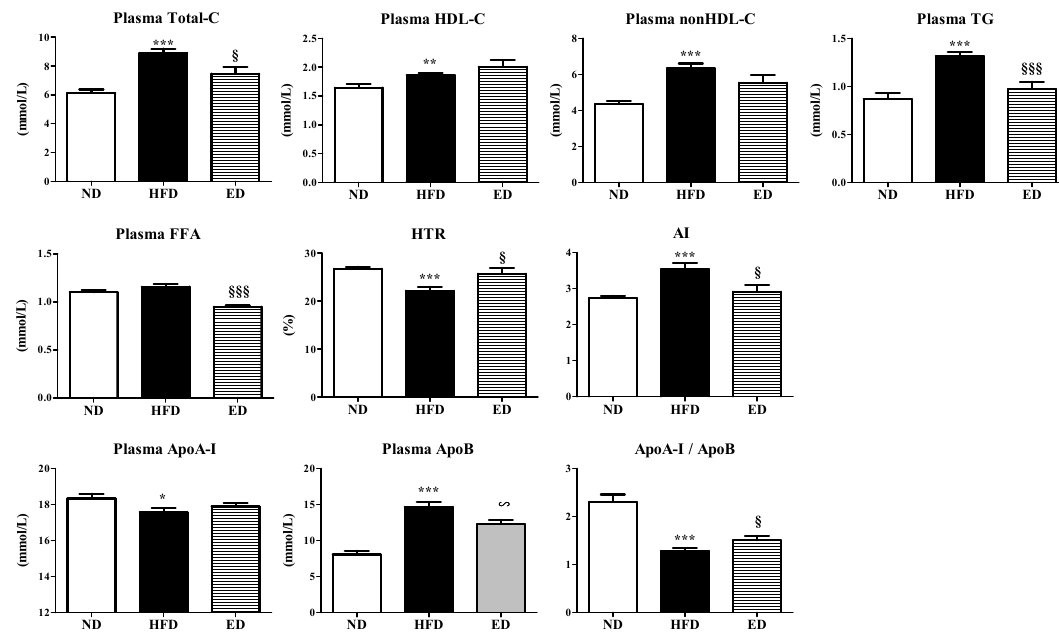
Figure 2. Effect of eriodictyol treatment on the plasma lipid levels in C57BL/6N mice fed with the high-fat diet (HFD). Data are presented as means ± SEM. Normal diet (ND; AIN-76) vs. HFD; * p < 0.05, ** p <0.01, *** p < 0.001. HFD vs. ED (HFD + 0.005% ED); § p < 0.05, §§§ p < 0.001. Total-C, total-cholesterol; HDL-C, high-density lipoprotein-cholesterol; TG, triglyceride; FFA, free fatty acid; HTR, HDL-cholesterol-to-TC ratio; AI, atherogenic index; Apo, apolipoprotein.